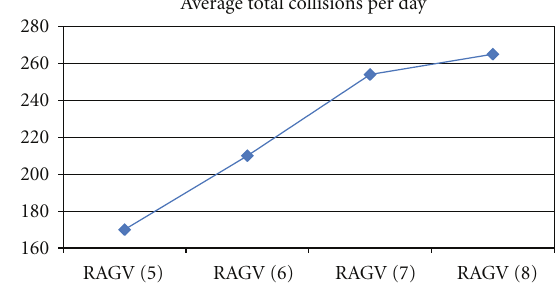
Figure 4: Average total collisions per